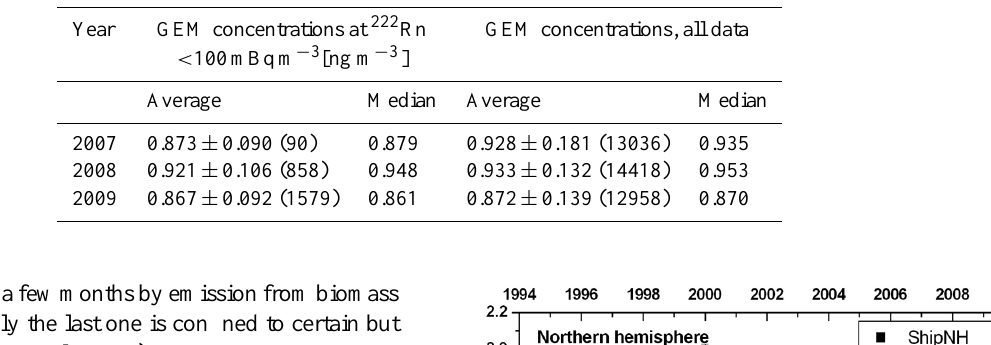
Table 1. Average mercury concentrations and medians of all data measured at Cape Point by the continuous technique and data measured at concentrations of 222 Rn < 100mBqm − 3 .The standard deviations and number of measurements are also given.